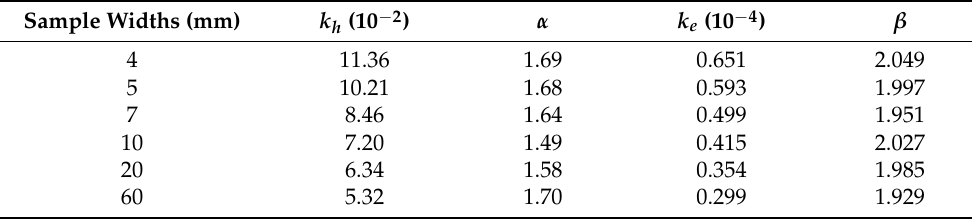
Table 4. Coefficients k h , k e , α , and β approximating the specific loss characteristics of electrical steel sheets M270-35A as a function of the width of the sample cut with a laser for the frequency ≥ 4000 Hz and the induction range up to